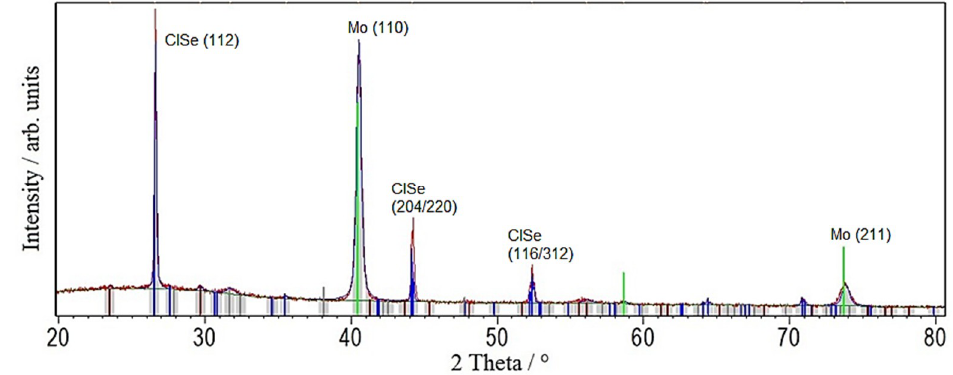
Figure 2. XRD pattern of a CuInSe 2 (CISe)-film from Cu-In + Se nanoparticle precursor after face-to-face annealing at 550 °C for 5 min with 46.1 kN/m² pressure.